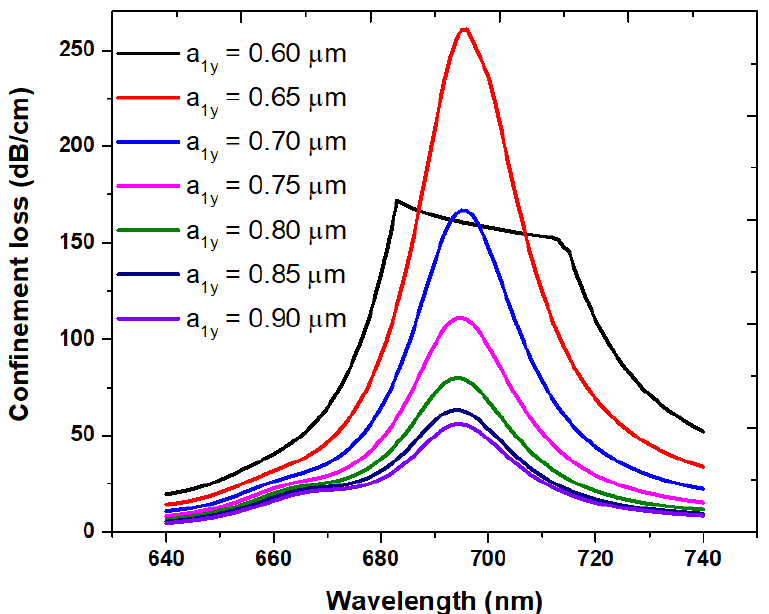
Figure 5. Confinement loss spectra of the core-guided mode for a 1 y = (0.60, 0.65, 0.70, 0.75, 0.80, 0.85, 0.90) µm.